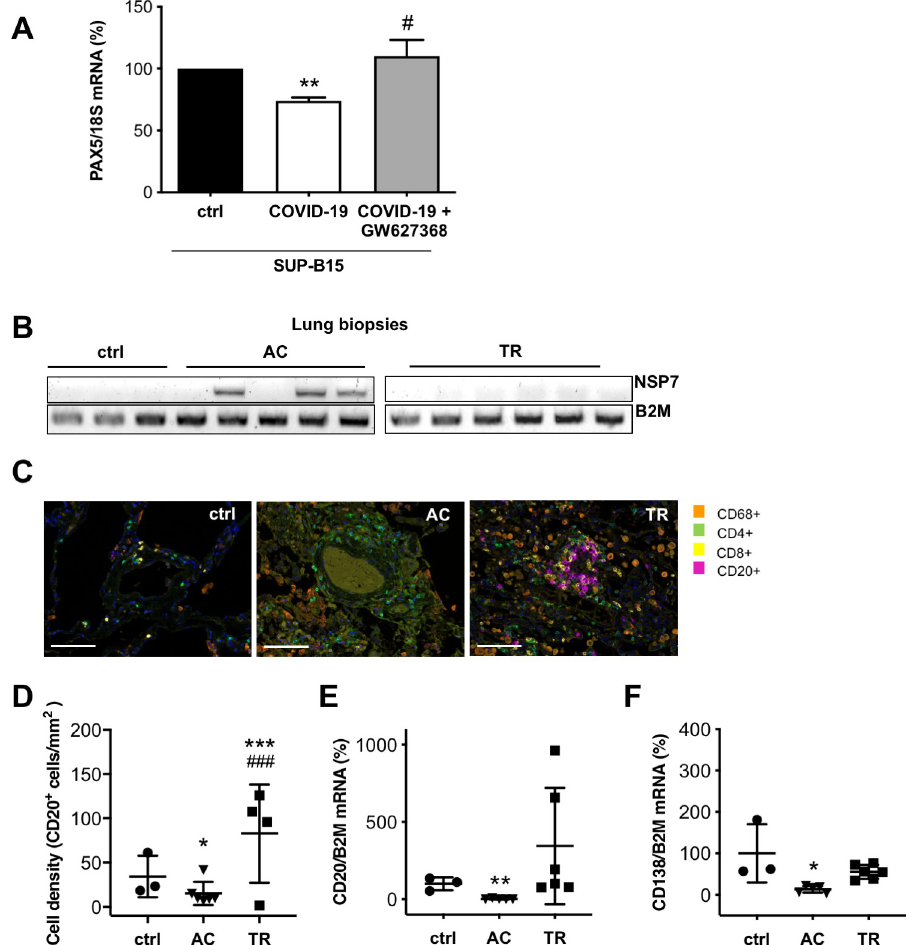
Fig 5. Modulation of the immune response in COVID-19 patients. (A) The bar graph summarizes PAX5 mRNA expression of SUP-B15 pre-B-cells treated with serum from healthy controls (serum pooled from 9 controls) and from COVID-19 patients (serum pooled from 9 COVID-19 patients) incubated with and without GW627368 (10 μ M). Control cells were treated with the solvent DMSO (n = 6 wells with control serum and n = 3 wells with serum of COVID-19 patients with and without GW627368). (B) Representative gel image of NSP7 and B2M mRNA expression in control lung tissue (ctrl), in lung tissue of patients with severe acute COVID-19 disease (AC) and in lung tissue obtained after transplant rejection (TR). (C) Immunohistochemical staining for CD68 + , CD4 + , CD8 + and CD20 + immune cells (scale bar: 100 μ m), (D) Dot plot summarizing the immunohistological quantification of CD20 positive B-cells per area (mm), dot plots summarize mRNA expression of (E) CD20 and (F) of CD138 in control lung tissue (ctrl), in the lung tissue of patients with severe acute COVID-19 disease (AC) and in lung tissue obtained after transplant rejection (TR). (A) One sample t-test, �� P < 0.01 vs. ctrl, # P < 0.05 vs. serum from COVID-19 patients. (D) Statistical analysis was performed using the generalized linear model with Gaussian distribution and weights adjusted according to the number of ROIs per patient, ��� P < 0.001 vs. ctrl, ### P < 0.001 vs AC. (E, F) unpaired two-tailed t -test, �� P < 0.01 vs. ctrl, � P < 0.05 vs. ctrl. Underlying data can be found in S1 Data and uncropped gel images in S7